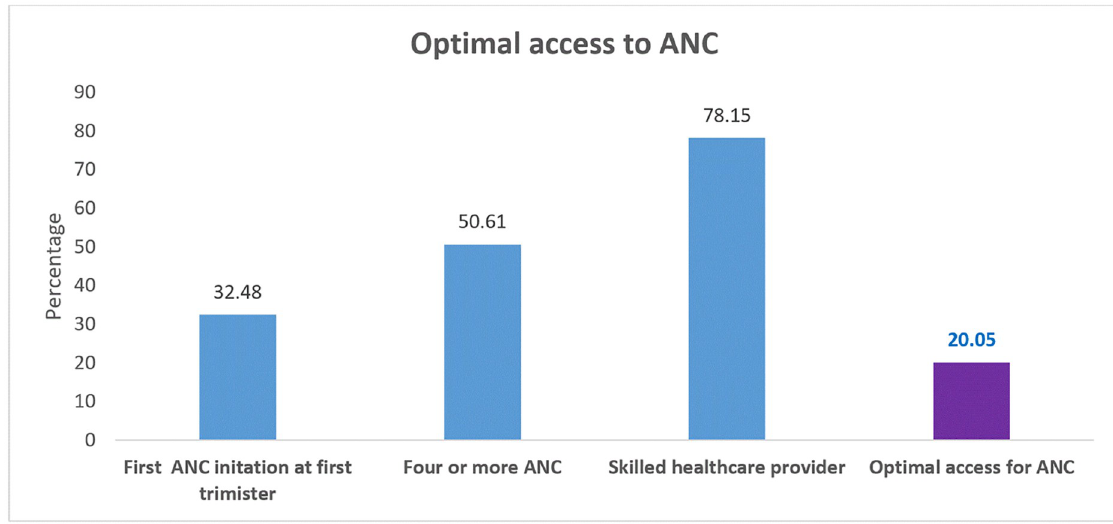
Fig 1. Optimal access to ANC among pregnant women in Ethiopia, 2016 (n =